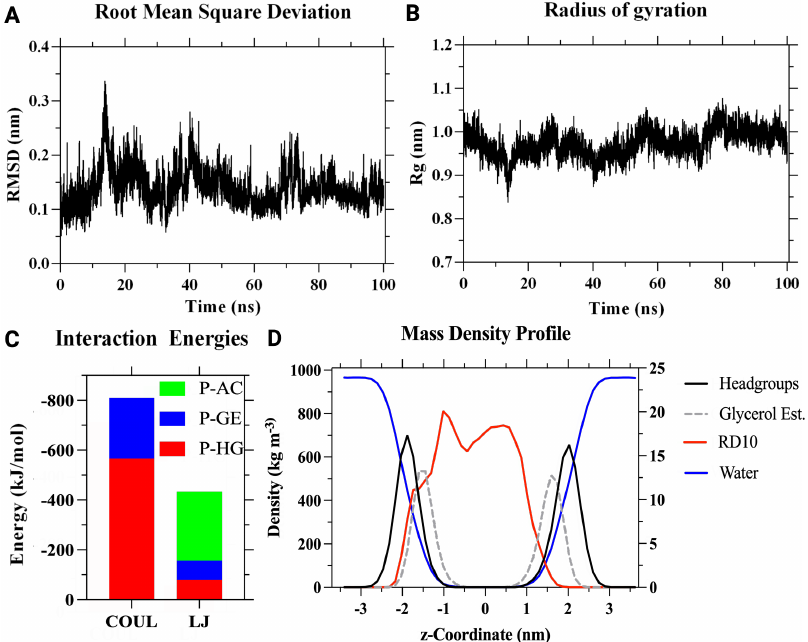
Figure 7. Stability of the RD10 peptide inside the cellular membrane. A minor variation on ( A ) RMSD and ( B ) Rg indicates that the peptide maintains its 3D conformation along the translocation pro- cess. ( C ) Coulombic (COUL) energies dominate the interactions over Lennard-Jones (LJ) energies. Headgroups (P-HG) and acyl chains (P-AC) play a significant role in peptide-membrane interaction. ( D ) Density distribution of the peptide along the z -axis of the membrane. The right y -axis presents the density scale for peptides, while the left y -axis represents the membrane components and bulk water. It indicates that the peptide remained mainly within the acyl chains, with a minor fraction interacting with the